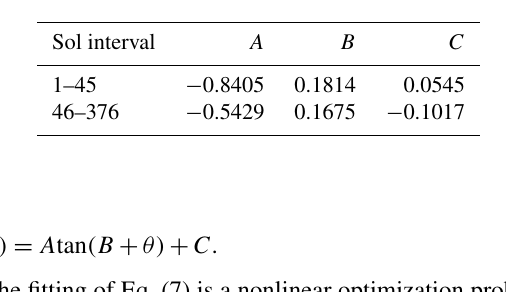
Table 3. The values of parameters A , B and C obtained from the LSQ fits.